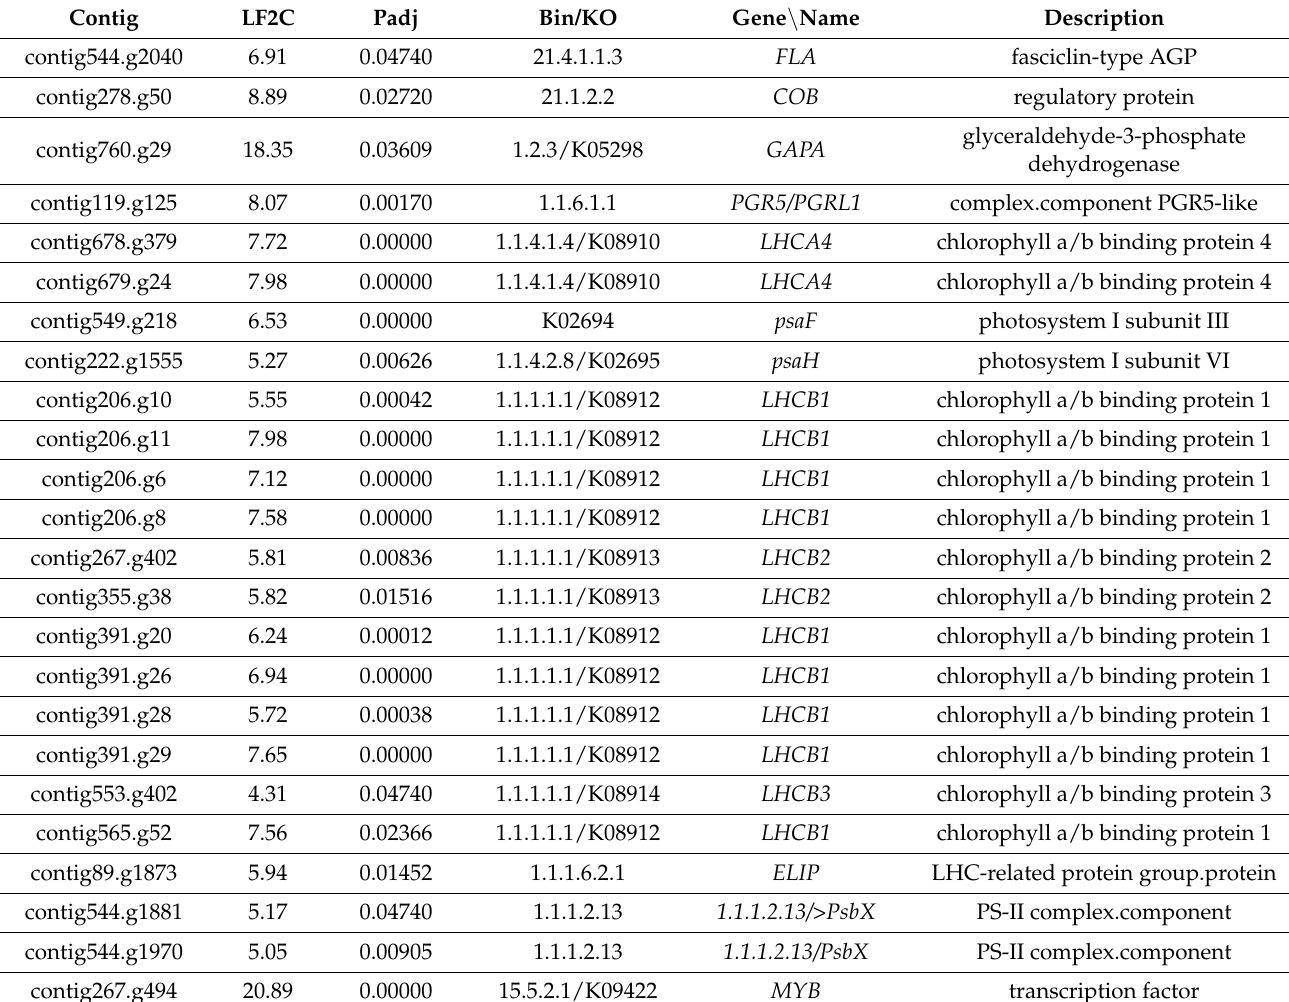
Table 1. Candidate genes associated with post-harvest hardening (PHH) in D. dumetorum tuber in the combined analysis of the hardening accessions 3DAH vs. AH.